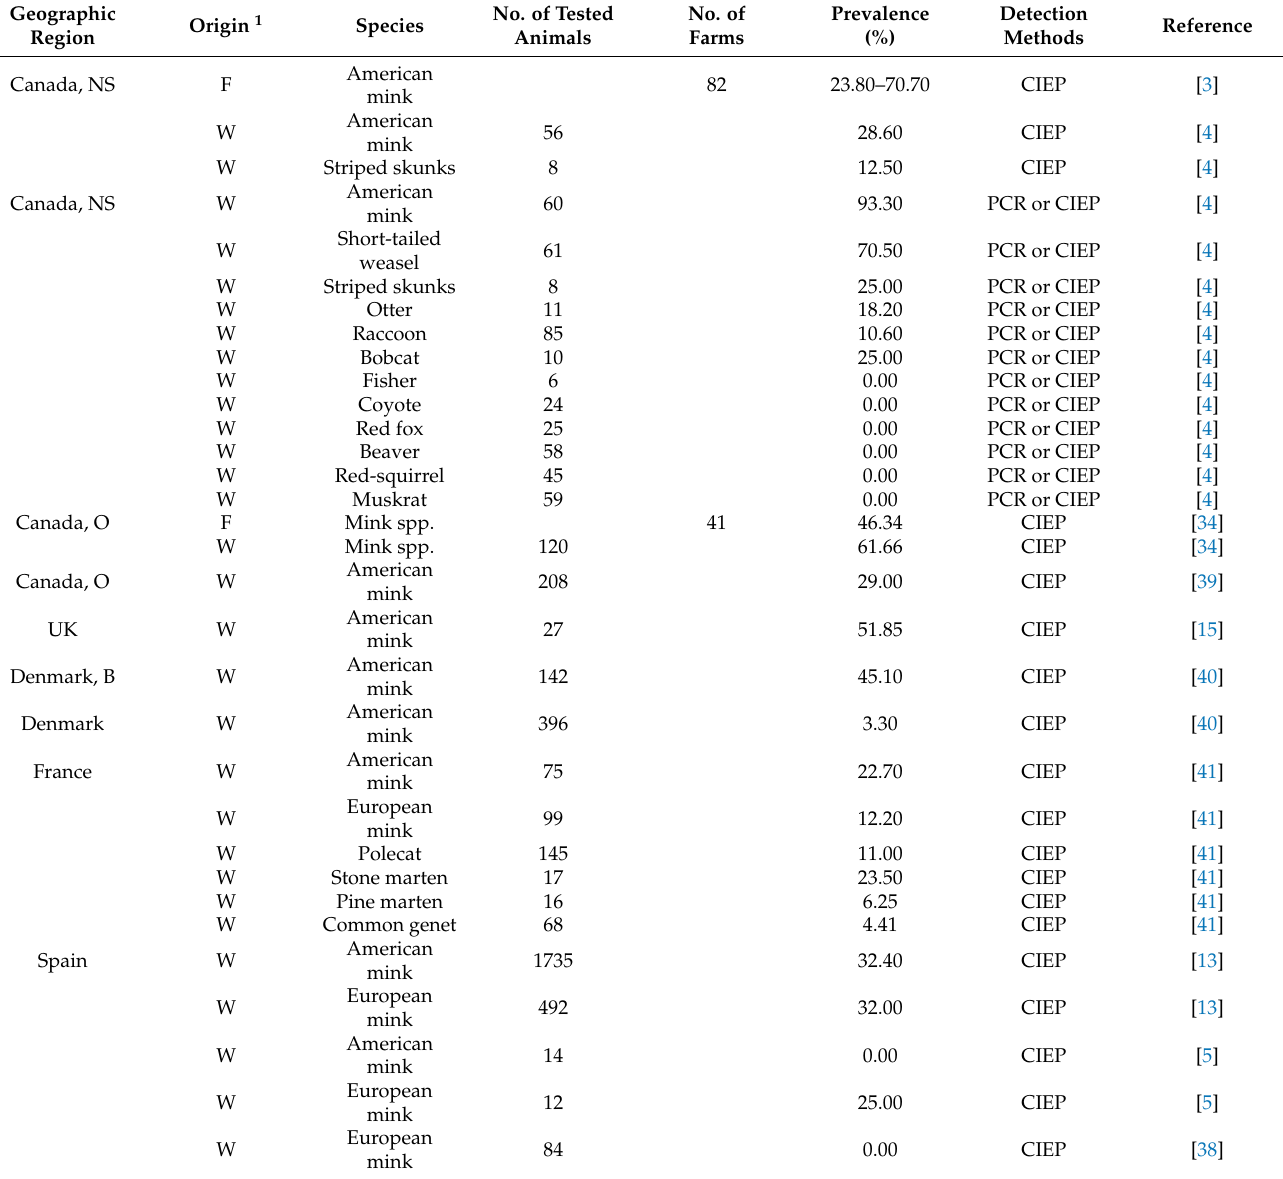
Table 1. Prevalence of anti-AMDV antibodies and AMDV DNA in American mink, European mink and other species. Geographic Region